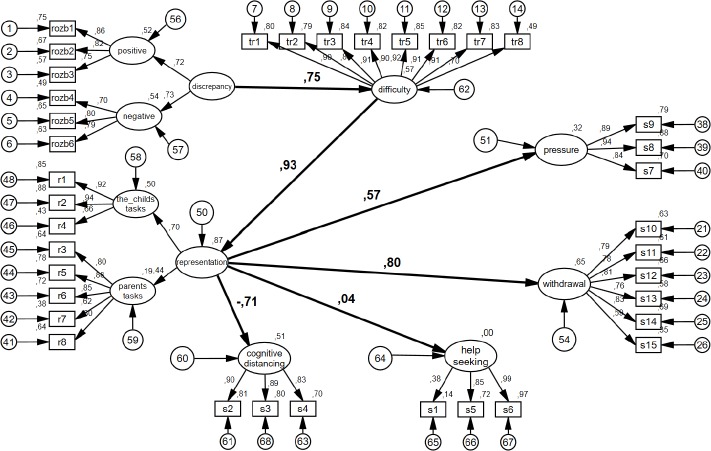
Graphical representation of the model.Standardized results. The relationships between the latent variables are bold.